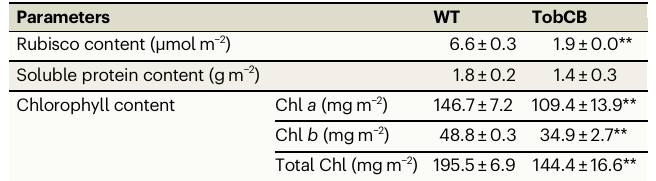
Table 2 | Comparison of the Rubisco content, protein content, and chlorophyll content of WT and TobCB